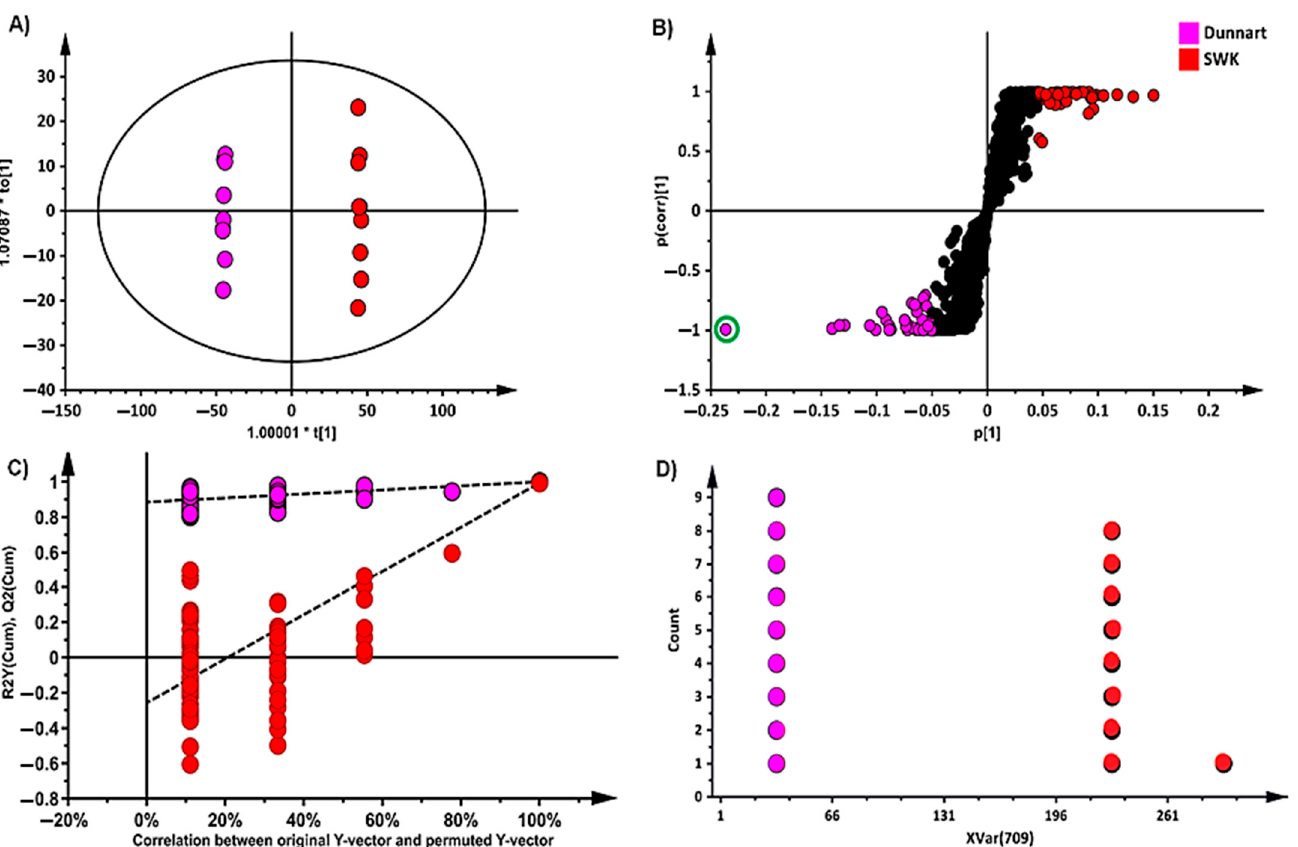
Figure 4. An orthogonal projection to latent structures discriminant analysis (OPLS-DA) model of two representative cultivars: ‘Dunnart’ and ‘SWK001’. ( A ) A score plot summarising the relationship among different datasets to visualise group clustering between the ‘Dunnart’ and ‘SWK001’ cultivars based on their leaf-extracted metabolic profiles obtained in ESI ( − ) MS mode (R 2 = 0.998, Q 2 = 0.971, CV-ANOVA p -value = 5.8941 × 10 − 14 ). ( B ) The corresponding loadings S-plot. The pink and red circles indicate the outlier values ( p (corr)[1] ≥ 0.5, ≤ − 0.5) and covariance of p [1] ≥ 0.05, ≤− 0.05) in the S-plot, indicating statistically significant ions that are possible discriminatory variables between the two cultivars. ( C ) Permutation test plot (n = 100) for the OPLS-DA model ( A ) was used to validate the predictive capability. ( D ) Dot plot illustrating strong discrimination between the cultivars for the selected variable (circled in green on the S-plot) as there is no overlap between the groups.